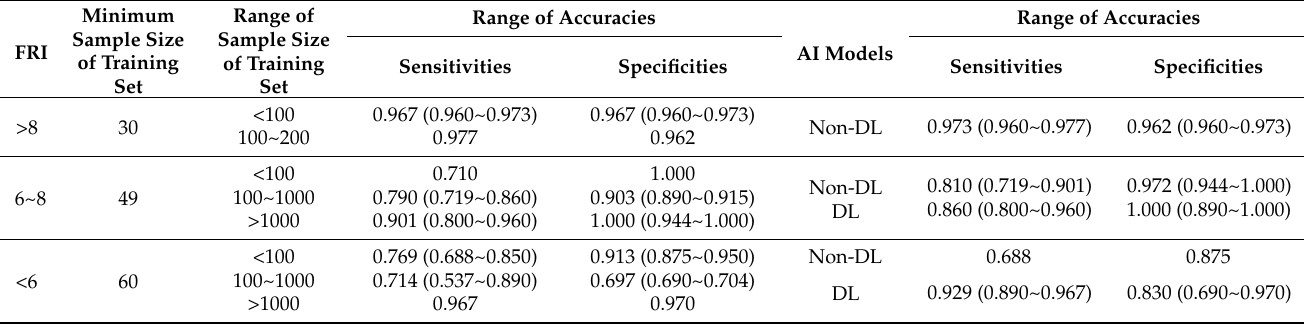
Table 4. Association between FRI, sample size of the training set, AI models, and accuracy of automatic diagnosis by facial recognition. FRI = facial recognition intensity, DL = deep learning. The diagnostic accuracy is shown as median (minimum,